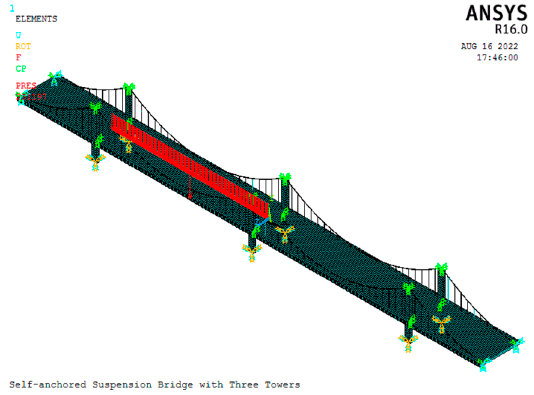
Figure 6. Finite element model of the Luozhou Bridge.